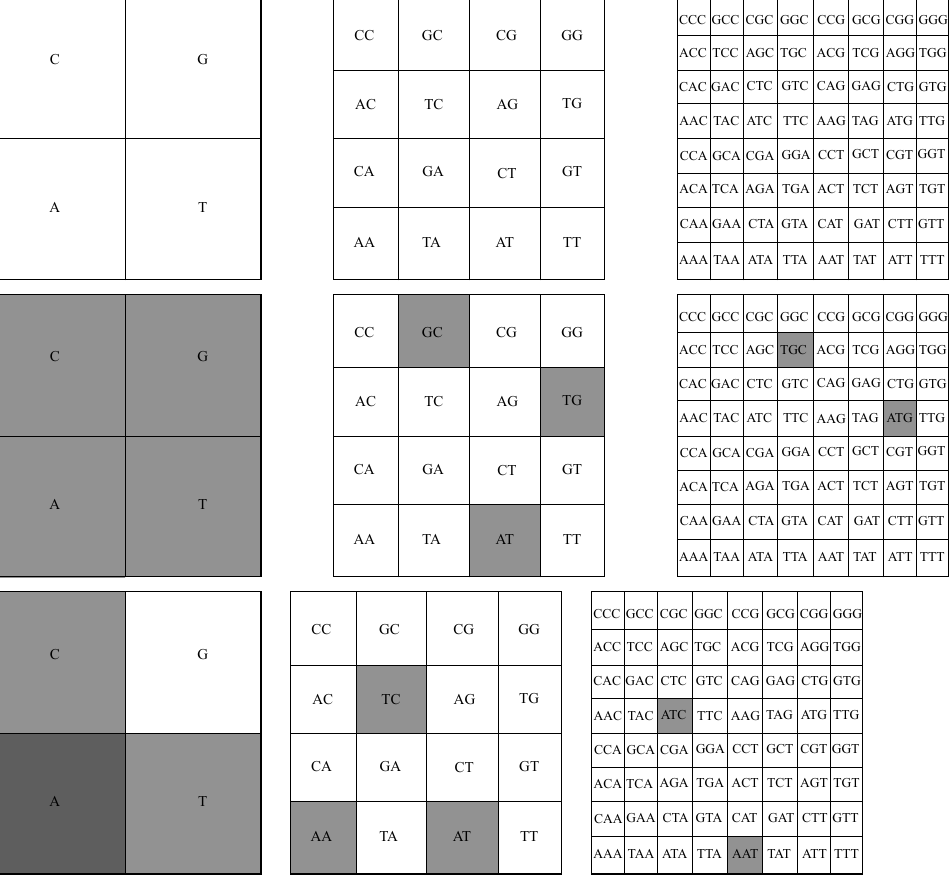
Figure 2. Quadrants in FCGR at different pixelation levels k , in which each quadrant corresponds uniquely to a specific string of length k . ( Left column ) k = 1. ( Middle column ) k = 2. ( Right column ) k = 3 (see text for details). ( Upper row ) Construction of quadrants, sub-quadrants and sub-sub-quadrants. ( Middle row ) FCGR representation of “ATGC” sequence. ( Bottom row ) FCGR representation of “AATC”